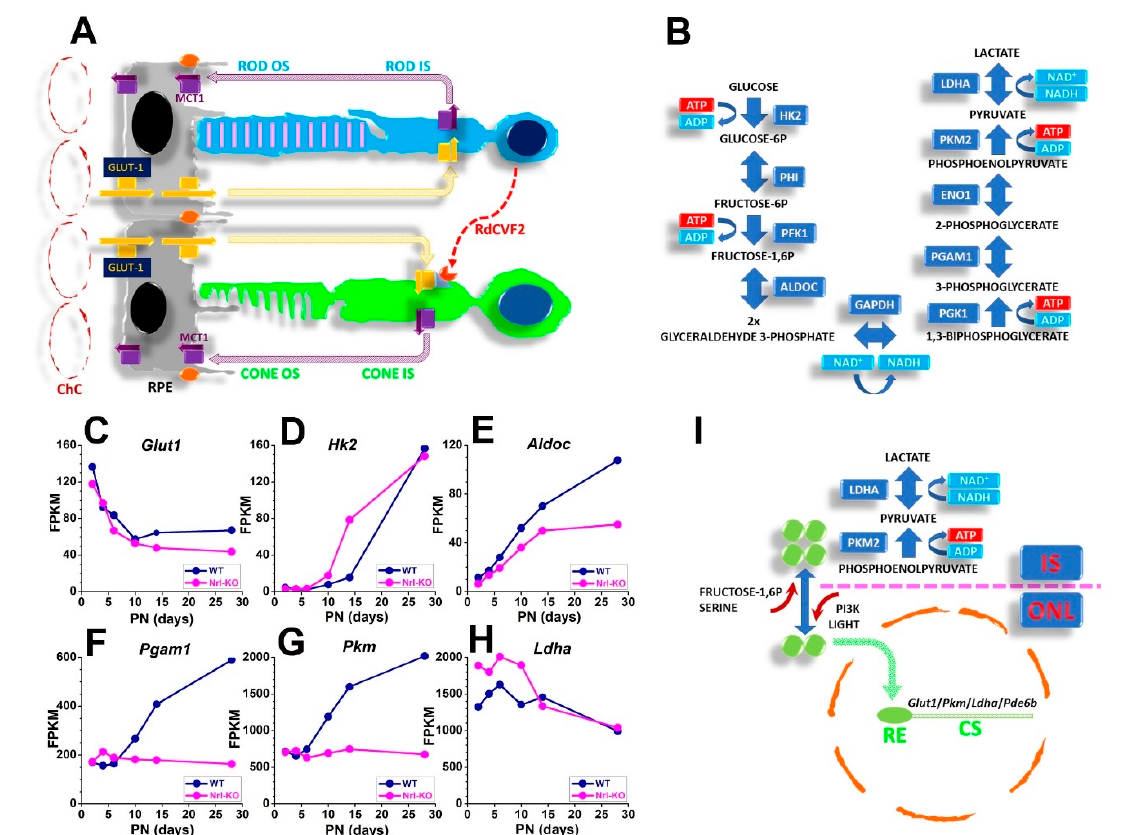
Figure 3. ( A ) Glucose diffuses from fenestrated choriocapillaris (ChC) and crosses the outer Blood Retinal Barrier (oBRB) represented by the tight junctions between RPE cells orange ellipses), reaching the SRS by permeating the basolateral and apical plasma membrane of RPE cells through the facilitated glucose transporter GLUT1 (yellow arrows and boxes). Glucose diffuses along a concentration gradient in the SRS (yellow dotted arrows) to reach GLUT1-expressing rod and cone cells. Lactate generated at the end of the glycolytic pathway is exported from photoreceptors through the monocarboxylate transporter MCT1 (purple arrows and boxes) and diffuses to RPE cells. RPE cells transport lactate and convert it to pyruvate for OXPHOS. Rods promote glucose use by cones by expressing and releasing RdCVF, whose receptor couples to GLUT1. RdCVF expression is strongly reduced in Nrl-KO mice (not shown). ( B ) Schematic representation of the primary enzymatic steps of glucose aerobic glycolytic metabolism, with boxes indicating enzyme isoforms expressed by photoreceptors. ( C – H ) Datapoints plot expression data (FPKM) for Glut1 ( C ), Hk2 ( D ), Aldoc ( E ), Pgam1 ( F ), Pkm ( G ), and Ldha ( H ) genes replotted from the RetSeq Database (see text) of transcriptome analysis of flow-sorted mouse rod precursors at different developmental ages, from postnatal (PN) days 2, 4, 6, 10, 14, and 28. Blue and magenta circles plot data for rods isolated from wt and Nrl-KO mice, respectively. Note the prominent upregulation of Pgam1 and Pkm after PN6 in Nrl wt mice. ( I ) Fructose 1,6 diphosphate and serine (upward-pointing red arrow) promote PKM2 (green circles) conversion tetrameric assembly, while light and phosphoinositide 3-phosphate kinase (PI3K) (downward-pointing red arrow) promote the dimeric/monomeric forms. The dimeric/monomeric forms enter the cell nucleus (dotted green arrow) to bind response elements and promote the expression of selected genes, such as Glut1 , Pkm , Ldha , and Pde6b